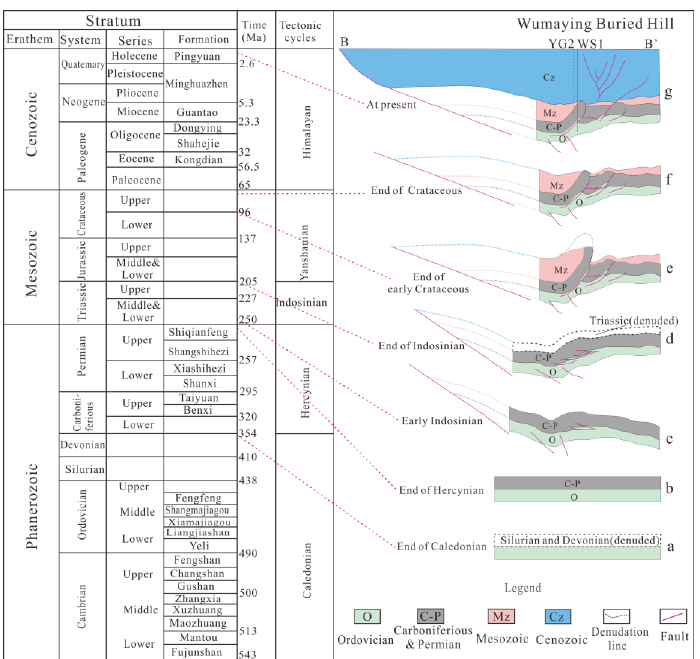
Figure 2. Structure evolution of the Wumaying buried hill (modified from [19]). The left side of the figure shows the stratigraphic timetable, and the right side shows the tectonic evolution of the Buried hill and the geological time corre- sponding to each tectonic event. B- B’ : Structural evolution of Wumaying Buried Hill. Buried hill and the geological time corresponding to each tectonic event. B-B’: Structural evolution of Wumaying Buried